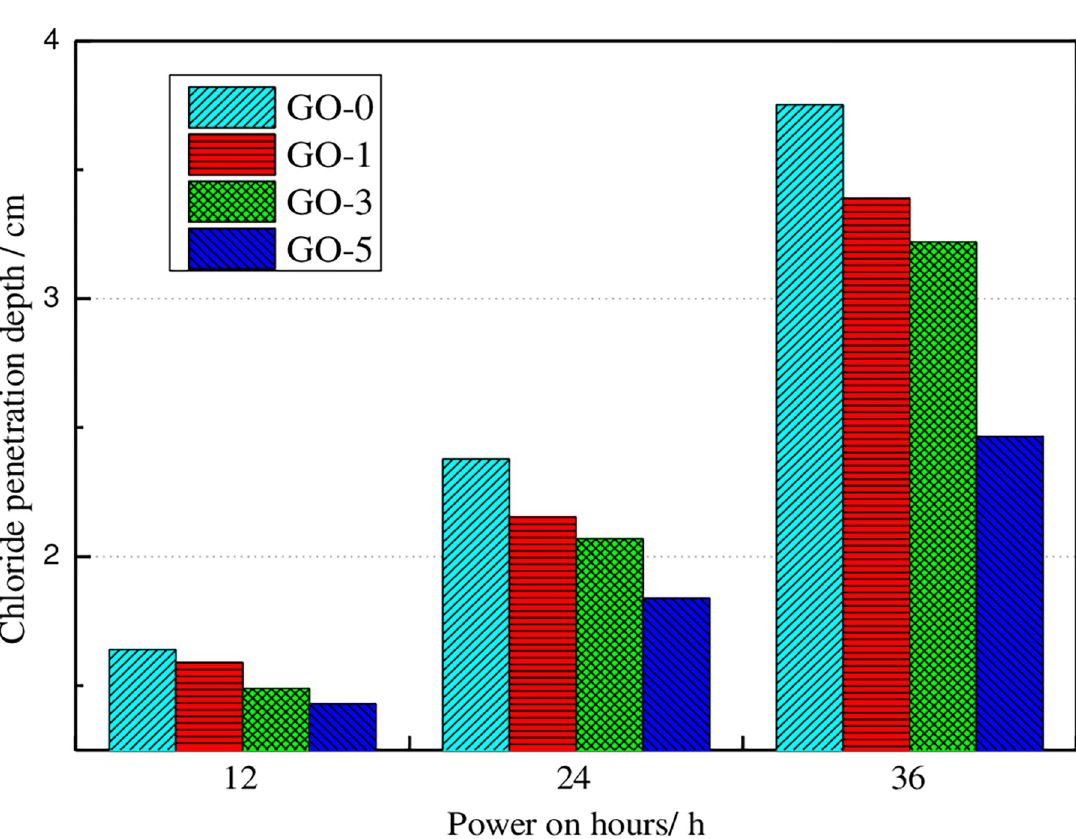
Fig 6. Chloride diffusion depths of GO added concrete under the various applied current